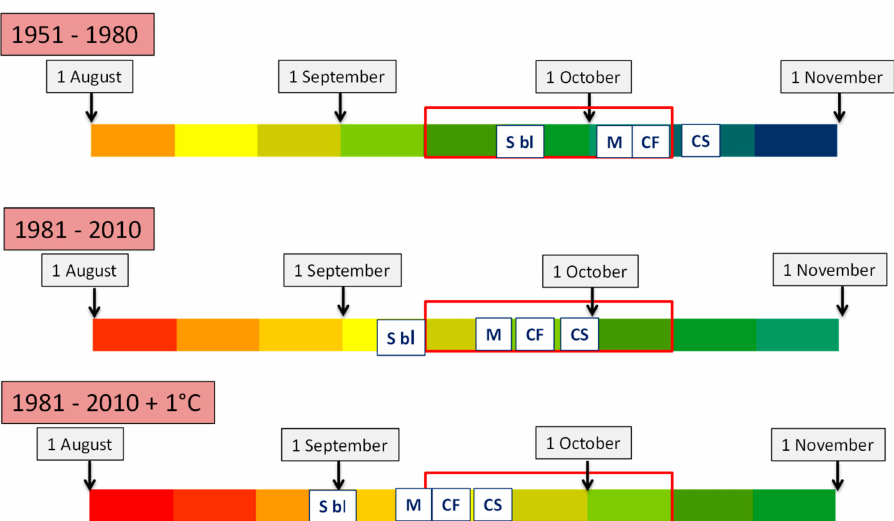
Figure 4. Modelled harvest dates for Sauvignon blanc (S bl), Merlot (M), Cabernet franc (CF), and Cabernet-Sauvignon (CS) in Bordeaux for the following periods: 1951–1980, 1981–2010, and 1981–2010 + 1 ◦ C. Sugar ripeness is modelled with the grapevine Sugar Ripeness Model (GSR; [55]). Temperature data is from Bordeaux M é rignac weather station. Warm colors indicate higher temperatures and cold colors cooler temperatures.